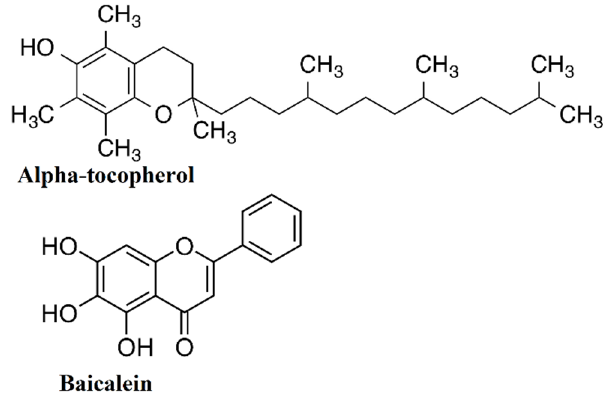
Figure 1. Chemical structure of α -tocopherol and baicalein.